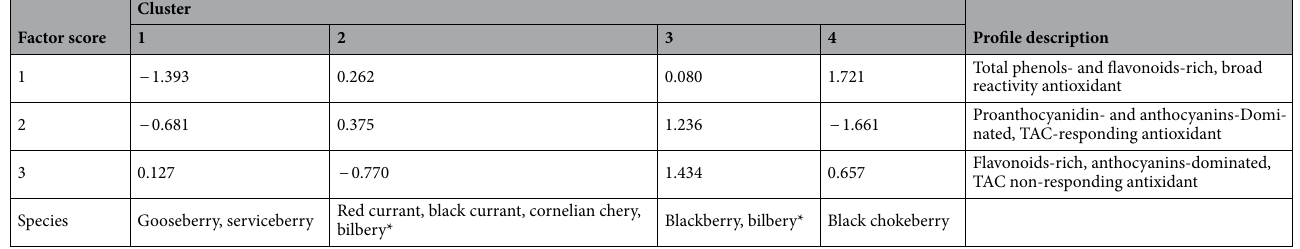
(Table 1) than the content previously reported for the same fruit species (e.g., 16.05 QE mg/100 g in serviceberry or 4.48 mg/100 g in black currant) 28 . Proanthocyanidins expressed as catechin equivalents ranged from 0.162 CE